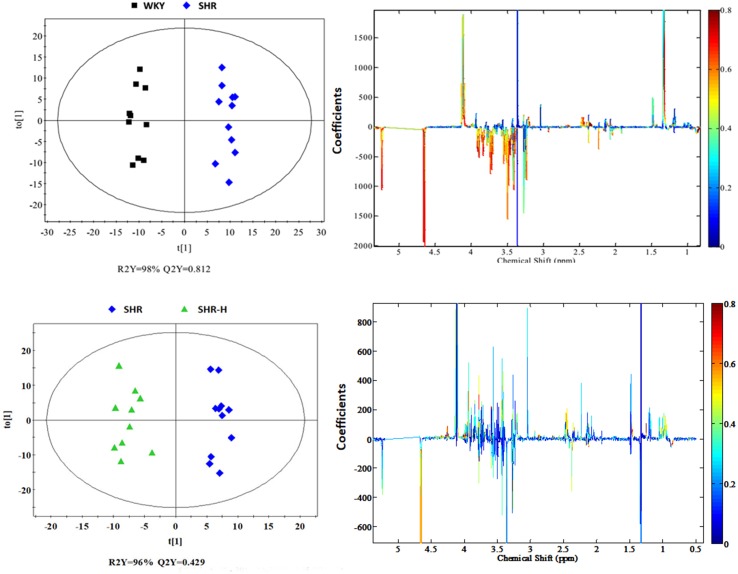
OPLS-DA score plots (left panel) and corresponding coefficient loading plots (right panel) derived from 1H NMR spectra of serum samples from the WKY, SHR and SHR-H groups.